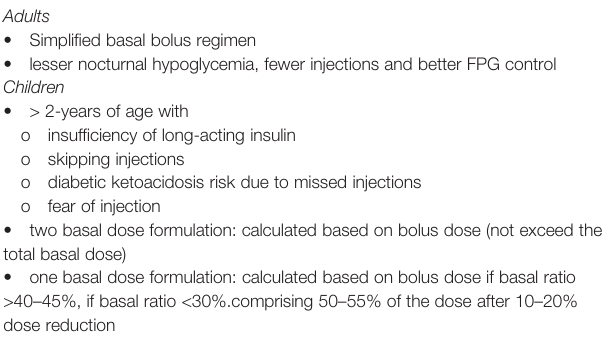
TABLE 8 | Expert Panel Recommendation 8: Use in Type 1 DM.